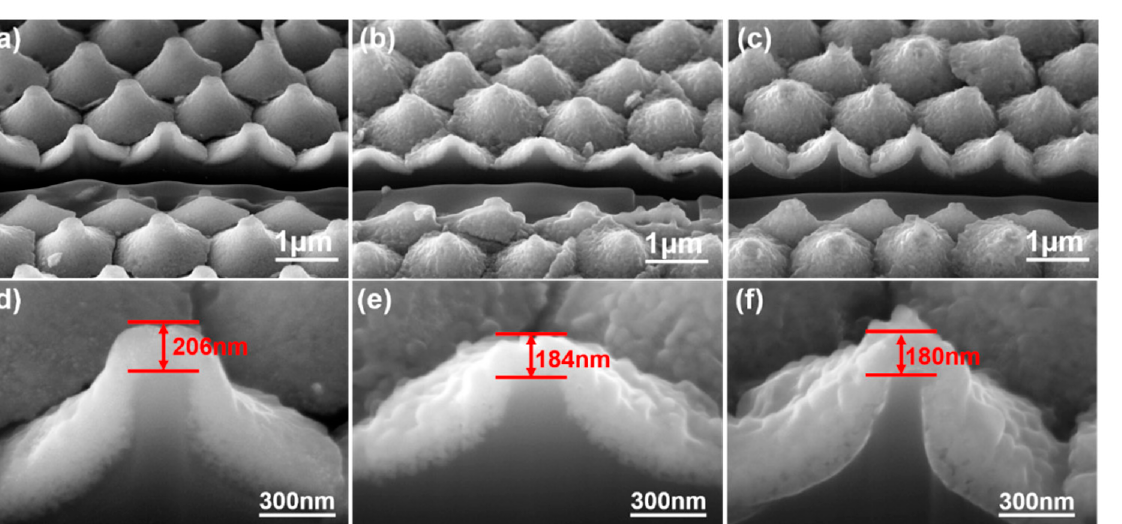
Figure 3. Low ‐ magnification SEM images of the surface of a prepared ZnO seed layer on Al sacrifi ‐ cial layers of different thicknesses: ( a ) 120, ( b ) 420, and ( c ) 720 nm. High ‐ magnification SEM images of the surface of a prepared ZnO seed layer on Al sacrificial layers of different thicknesses: ( d ) 120, ( e ), 420, and ( f ) 720 nm.